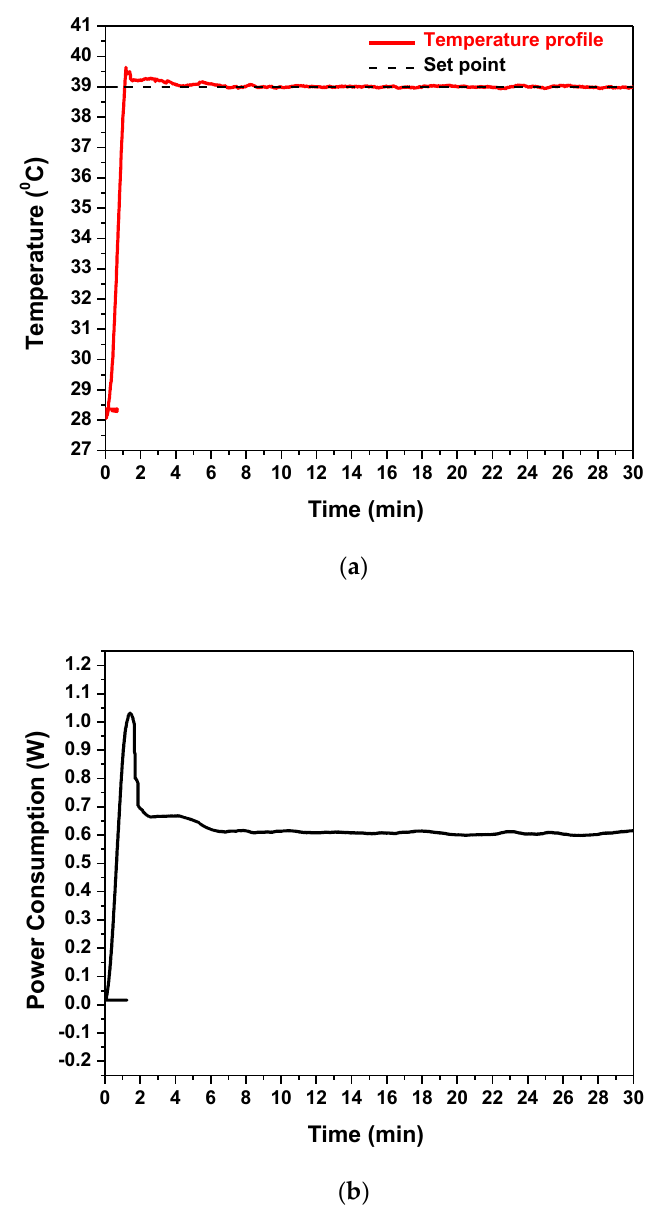
Figure 5. ( a ) The temperature profile of the embedded Cu microheater after heating up to set-point temperature and ( b ) its power consumption.